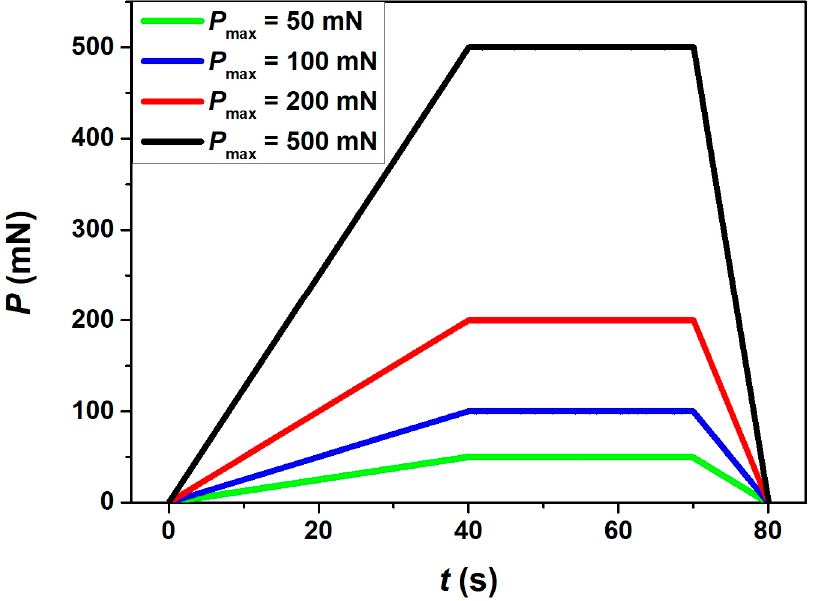
Figure 3. Schematic illustration of load ( p )–time ( t ) plot used in the nanoindentation